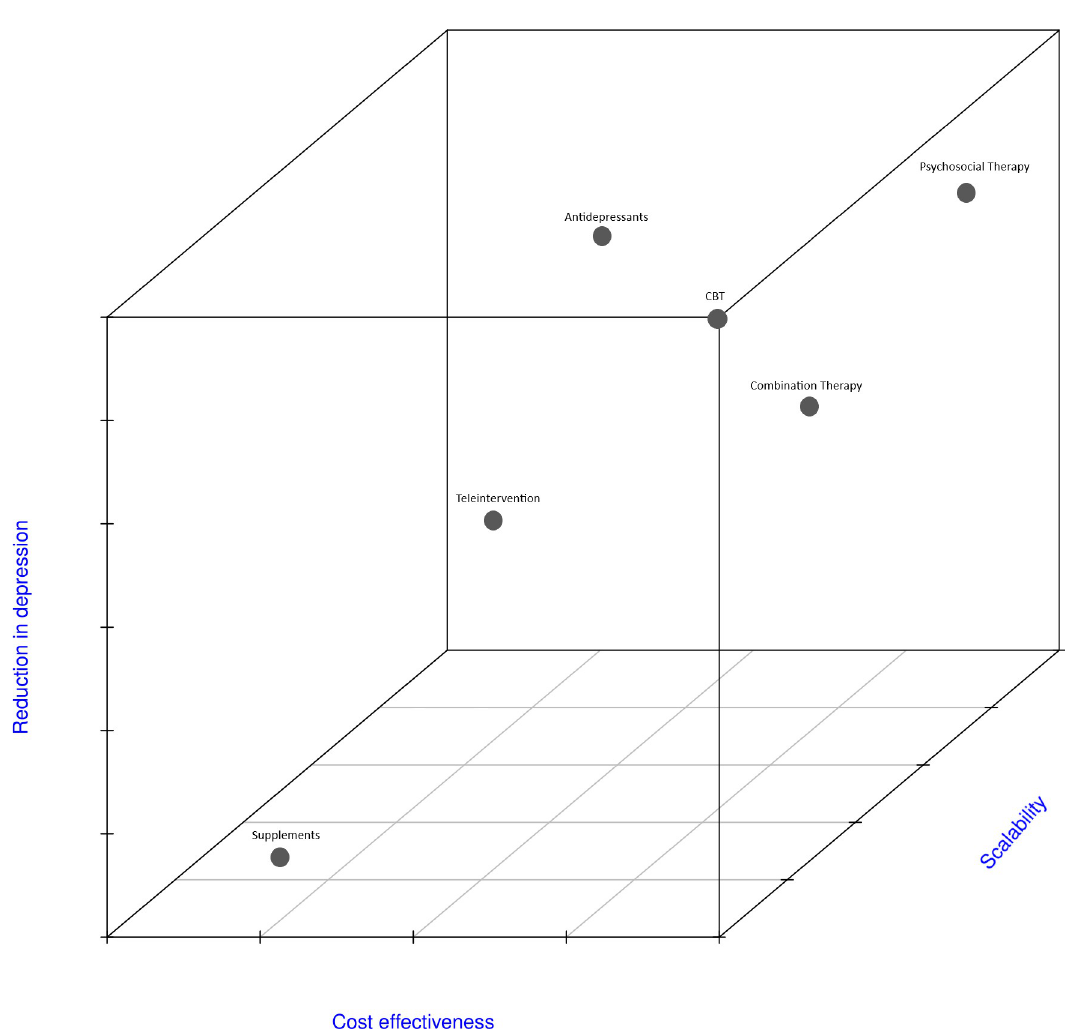
Fig 4. Effectiveness of interventions based on cost-effectiveness, reduction in depression and scalability.